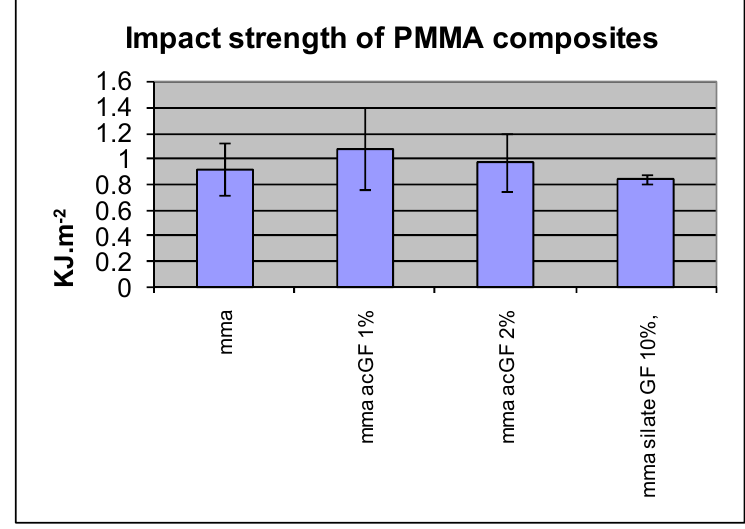
Figure 13. E ff ect of adding filler particles on impact strength of Figure 13. Effect of adding filler particles on impact strength of resins. Table 2. Effect of adding filler particles on impact strength of resins.